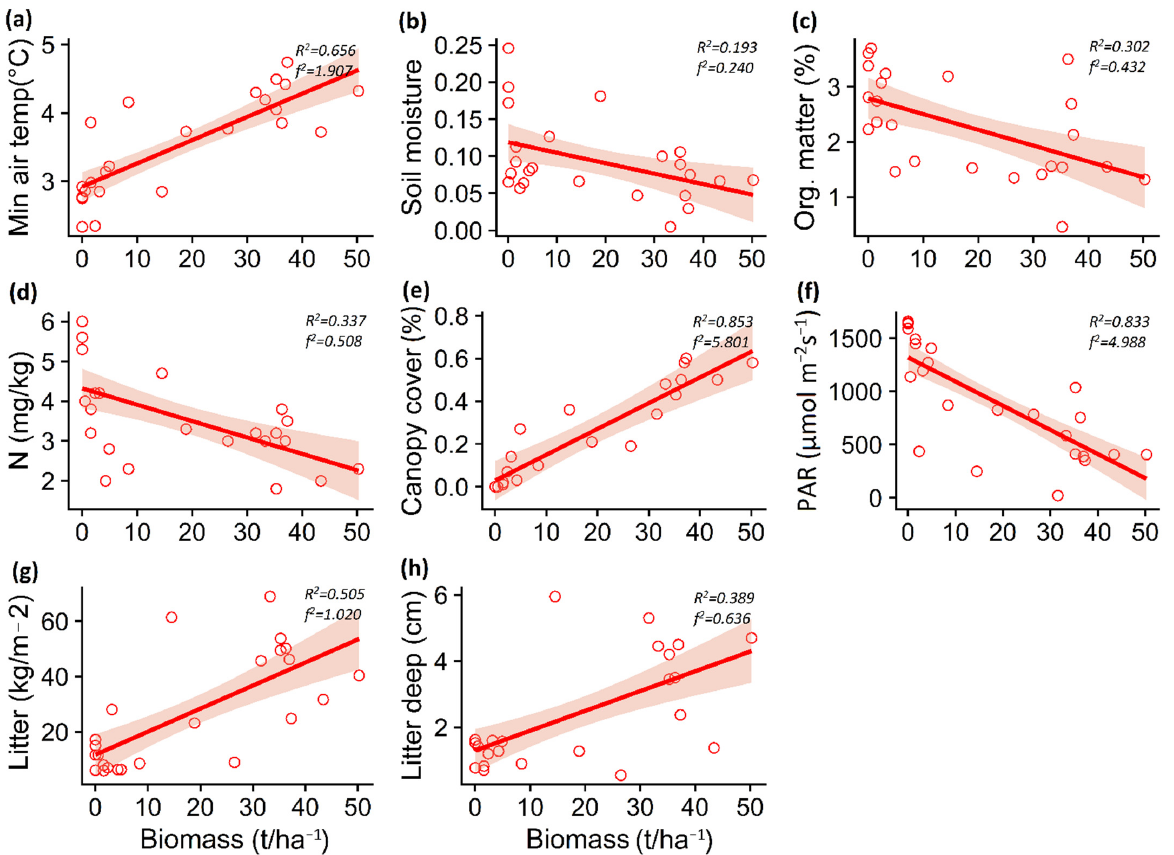
Figure 4. Relationship between Pinus contorta biomass and minimum air temperature ( a ), soil moisture ( b ), organic matter ( c ), nitrate content ( d ), canopy cover ( e ), PAR light ( f ), total litter ( g ), and litter depth ( h ) for Patagonian steppe. The lines show the linear model fit and the 95% confidence interval. R 2 is the adjusted R 2 .